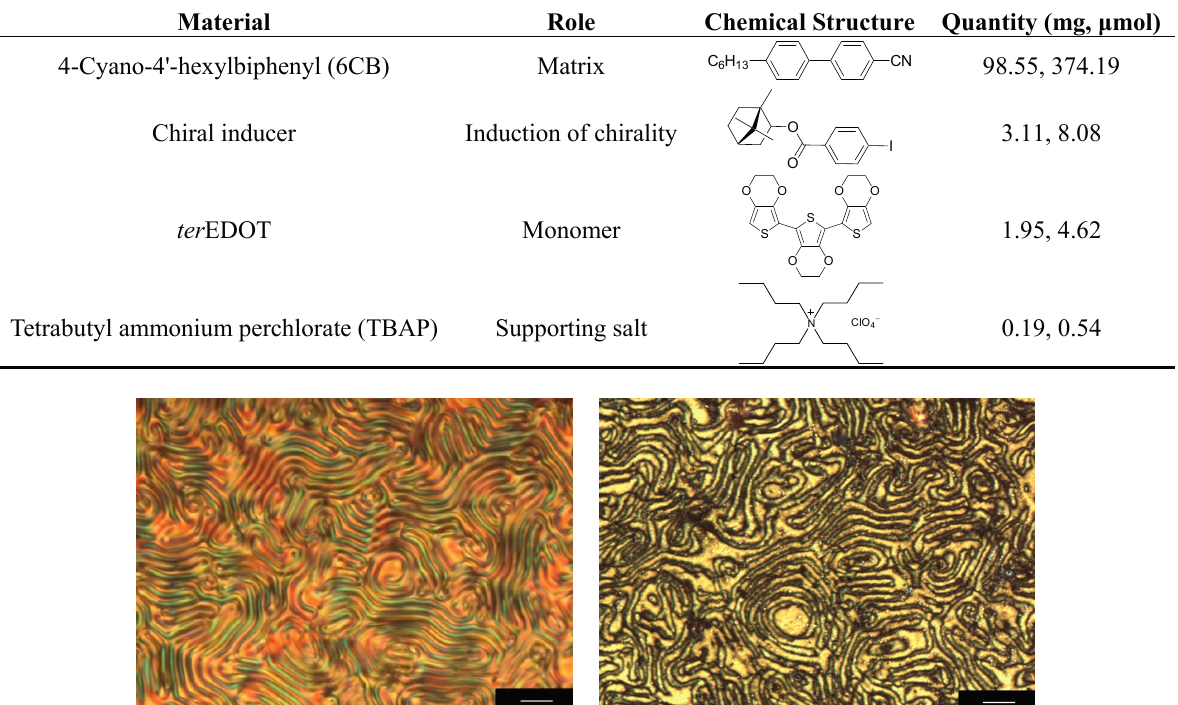
Table 2. Constituents of cholesteric liquid crystal electrolyte solution.